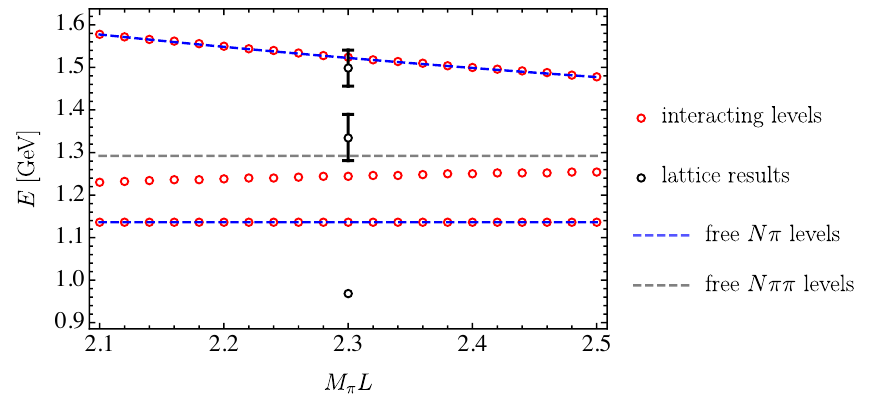
Figure 7 . Comparison of the Roper resonance energy levels with lattice results using the Nπ and Nσ self-energy contributions. Red circles display the numerical results for the interacting energy levels and black circles the lattice results with errors from ref. [38]. Blue dashed and grey dashed lines show the non-interacting Nπ and Nππ energy levels, respectively.